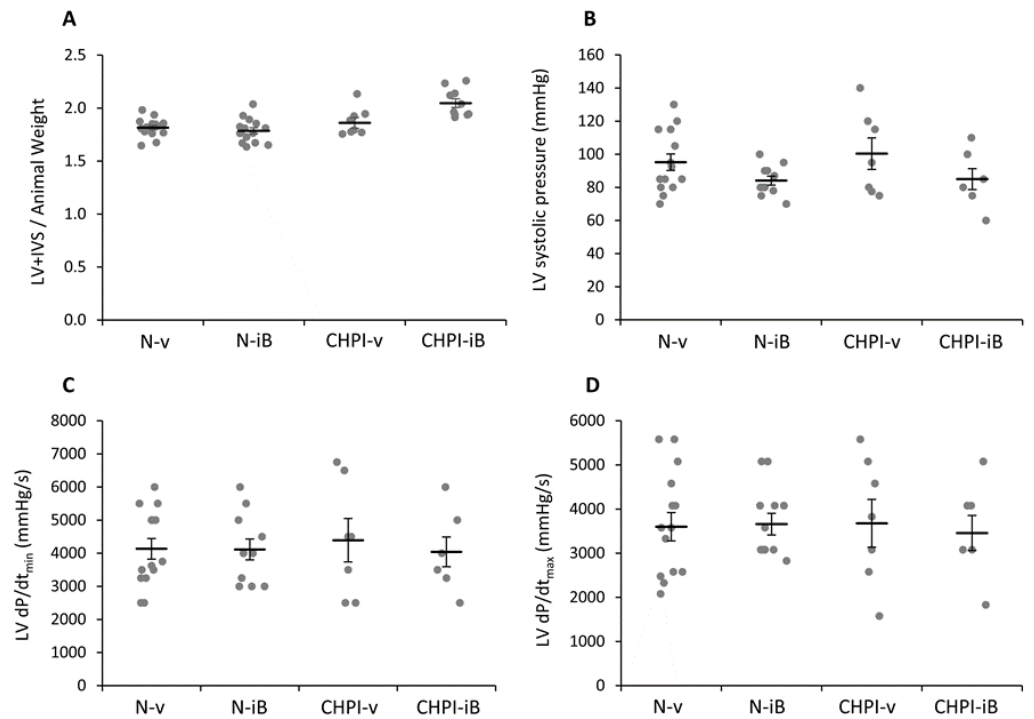
Figure 3. Effect of I-BET151 administration on the morphology and function of the left ventricle. Weight of left ventricle + interventricular septum normalized to the animal body weight ( A ); Left ventricular systolic pressure ( B ); Left ventricular relaxation time; ( C ) and contraction time ( D ). LV: Left Ventricle; IVS: Interventricular Septum; I-BET: Inhibitor of Bromodomains and Extra-Terminal domains; N-v: Normoxia + vehicle; N-iB: Normoxia + I-BET151; CHPI-v: Chronic Hypoxia + Inflammation + vehicle; CHPI-iB: Chronic Hypoxia + Inflammation + I-BET151. Horizontal bars represent the mean ± SEM; n = 6 – 16. #: diff. from N-v (#: p < 0.05; ##: p < 0.001).